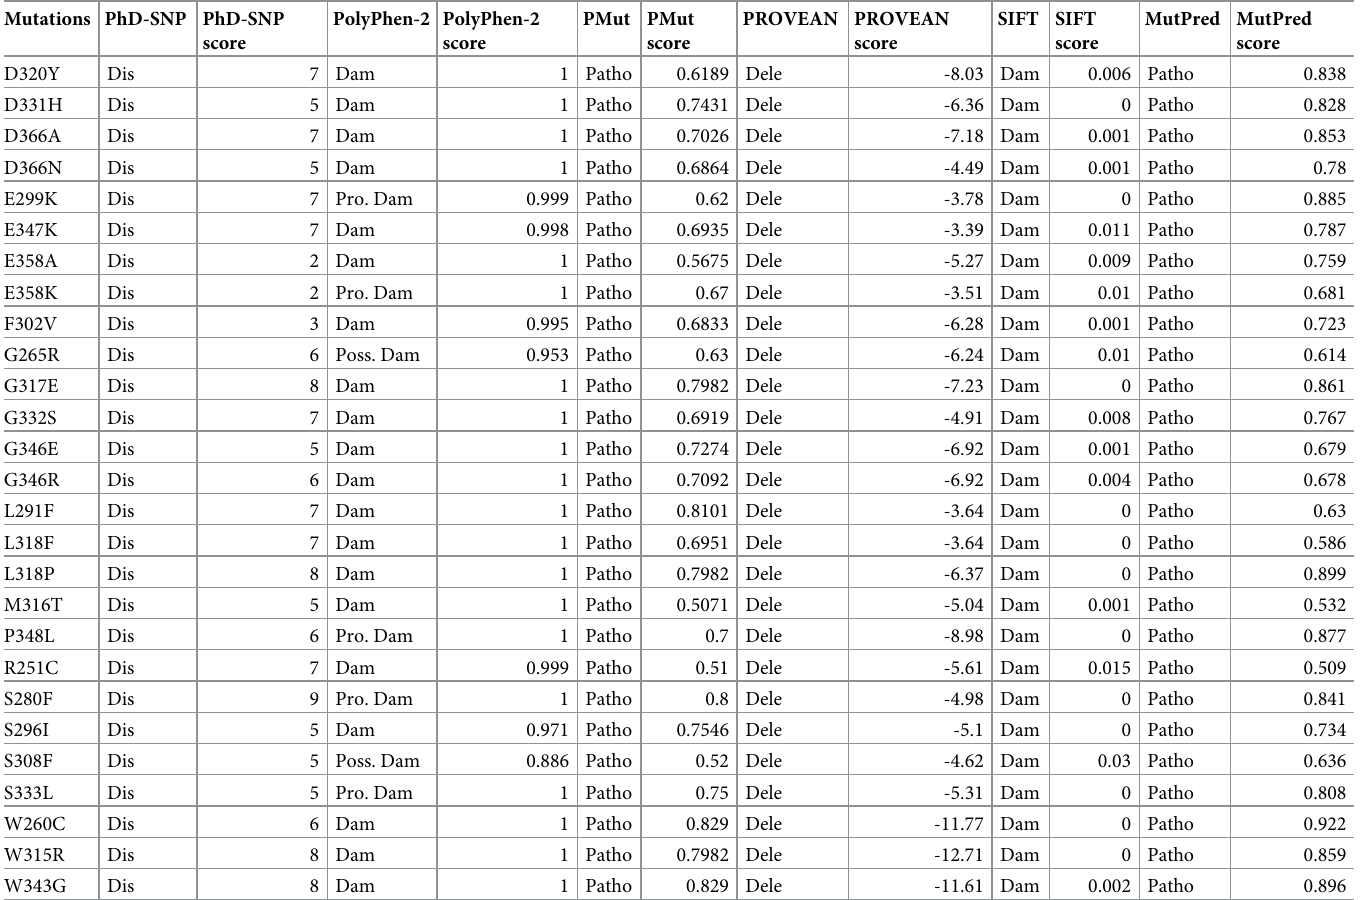
Table 2. List of 27 most deleterious missense SNPs along with their software scores. Mutations PhD-SNP PhD-SNP